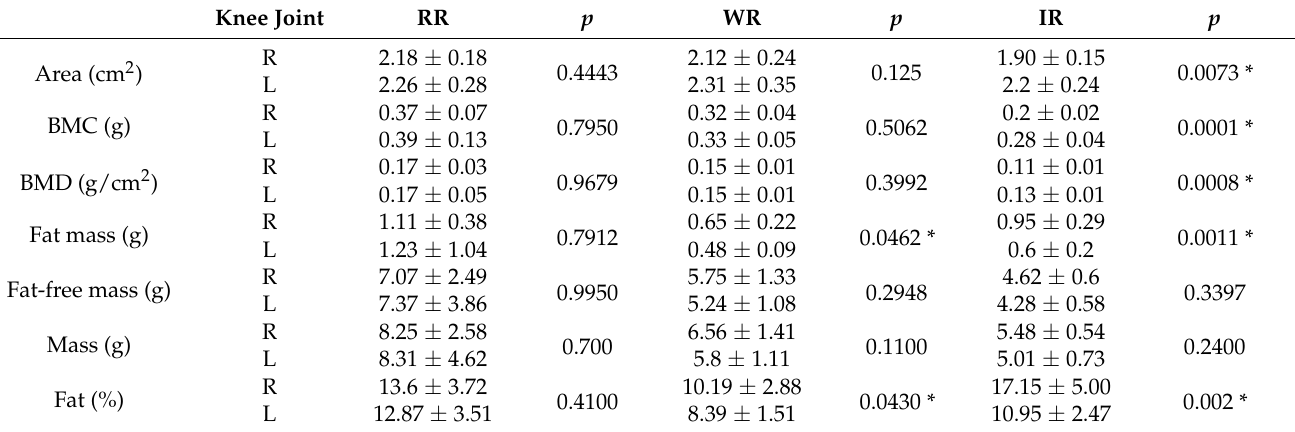
Table 2. Comparison of the parameters of both knee joints of the animals (right R vs. left L).